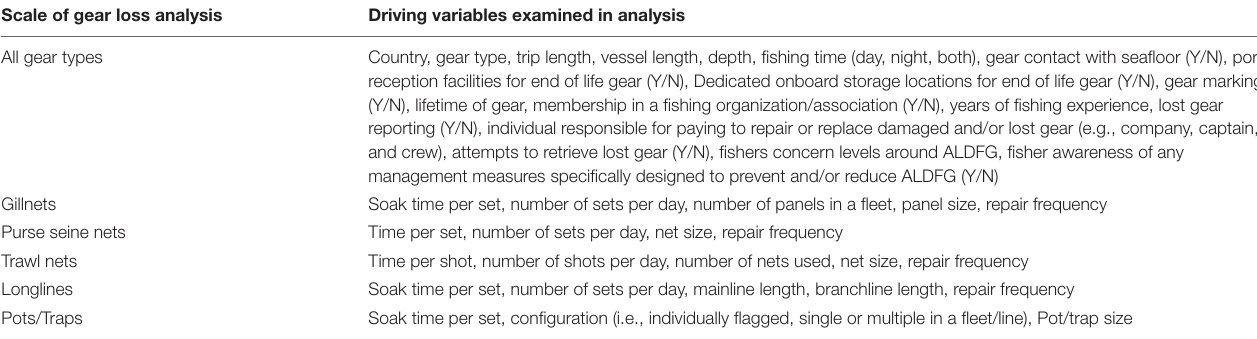
TABLE 1 | Driving variables examined across all gear types and countries, combined; and across all countries for each gear type (gillnets, purse seine nets, trawl nets, longlines, and pots/traps). Scale of gear loss analysis Driving variables examined in